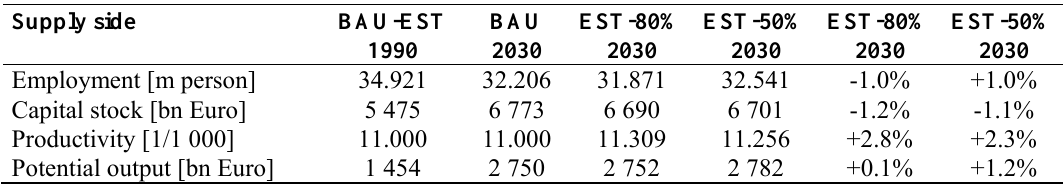
Table 4. Supply for BAU/EST